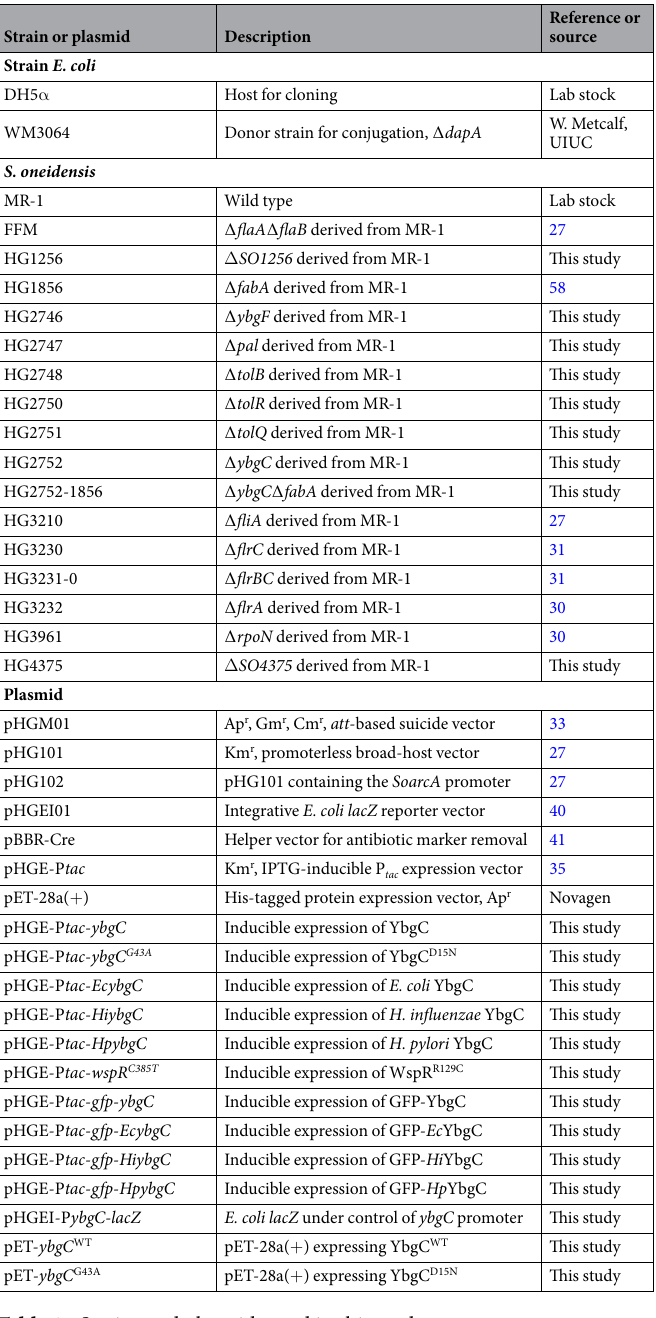
Table 1. Strains and plasmids used in this